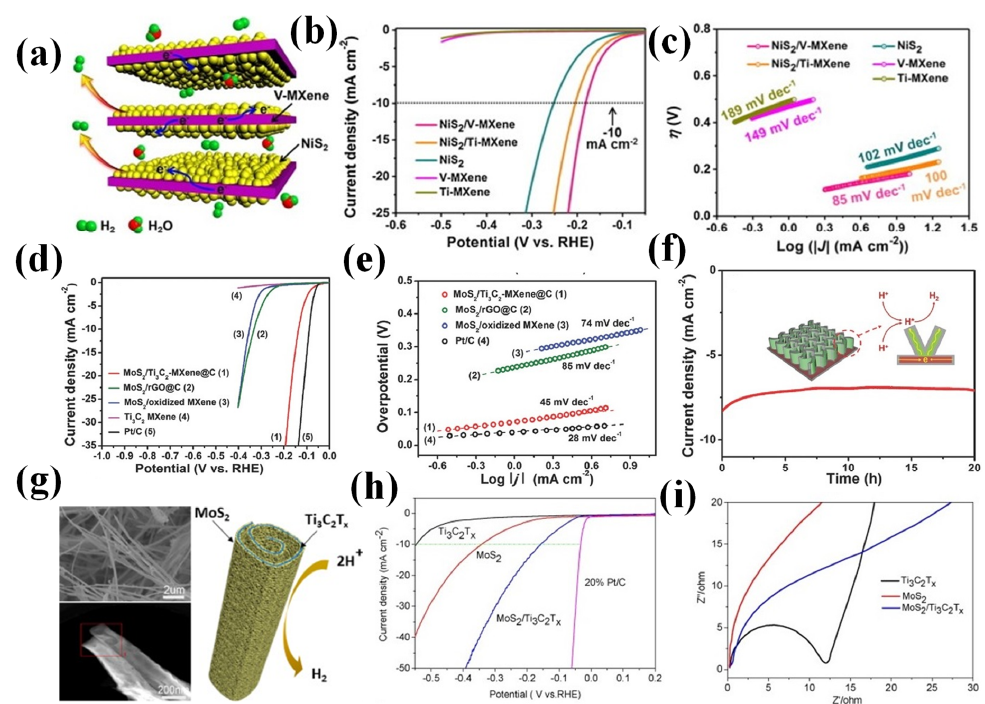
Figure 8. ( a ) Schematic illustration for strong electron transfer takes place from V-MXene to NiS 2 ; ( b ) polarization curves and ( c ) Tafel slopes of NiS 2 /V-MXene, NiS 2 /Ti-MXene, NiS 2 , V-MXene and Ti-MXene electrodes [44]; ( d ) polarization curves and ( e ) Tafel plots of MoS 2 /Ti 3 C 2 -MXene@C, MoS 2 /oxidized MXene, MoS 2 /rGO@C, Ti 3 C 2 MXene and Pt/C catalysts; ( f ) time-dependent current density curves for MoS 2 /Ti 3 C 2 -MXene@C catalyst at overpotential of −130 mV [82]; ( g ) SEM and TEM images of the “nanoroll” such as MoS 2 /Ti 3 C 2 T x hybrid; ( h ) polarization curves of MoS 2 /Ti 3 C 2 T x hybrid, Ti 3 C 2 T x nanosheets, and pure MoS 2 ; ( i ) EIS of MoS 2 /Ti 3 C 2 T x hybrid, Ti 3 C 2 T x nanosheets, and pure MoS 2 at overpotential of −100 mV [83].